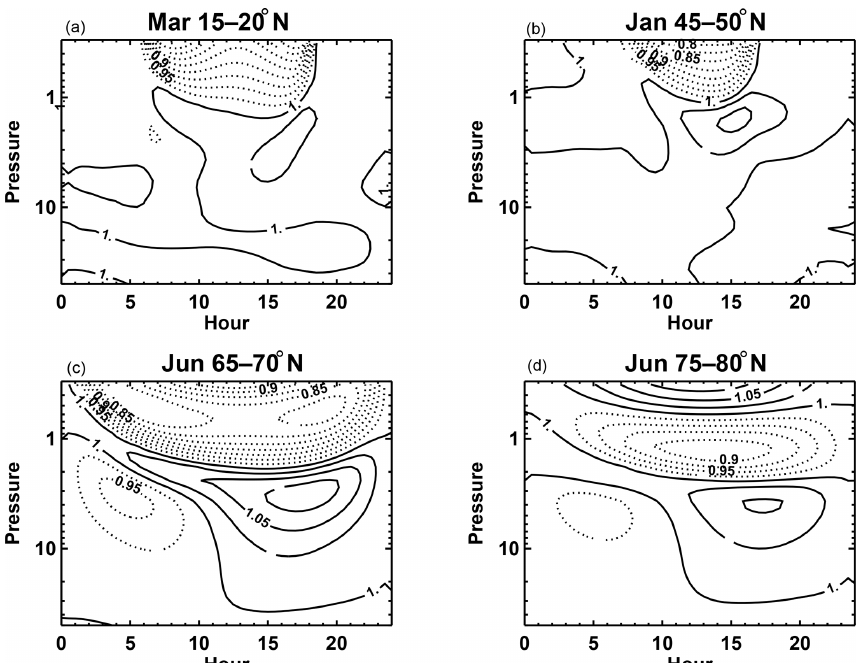
Figure 1. Contour plot of the GEOS-GMI diurnal ozone climatology (GDOC) normalized to the midnight value as a function of hour and pressure for March at 15–20 ◦ N (a) , January at 45–50 ◦ N (b) , June at 65–70 ◦ N (c) and June at 75–80 ◦ N (d) . The contour interval is 0.025 (2.5%). The climatology is shown at levels from 50 to 0.3hPa.